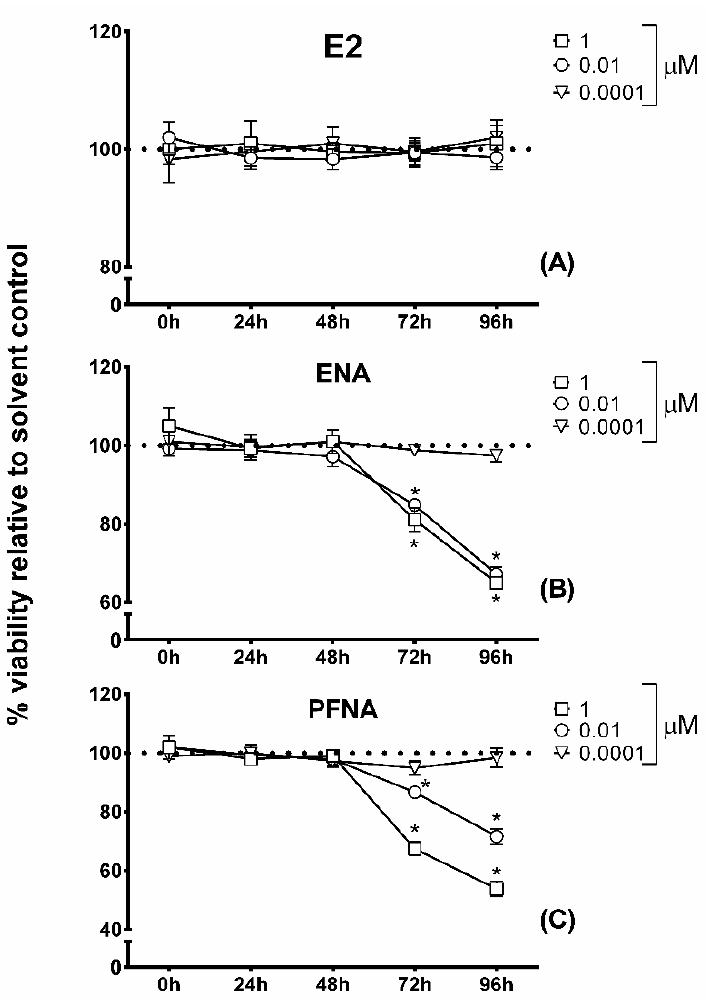
Figure 1. Alamar Blue cell viability of Mugil cephalus hepatocytes following exposure to E2 ( A ), ENA ( B ), PFNA ( C ) for up to 96 h. The dot line represents cell viability measured in the solvent control (assigned a survival of 100%). Values are given as mean ± SEM of three independent experiments and expressed as % relative to the solvent control. “*” indicates significant differences between control and treated groups ( p < 0.05).